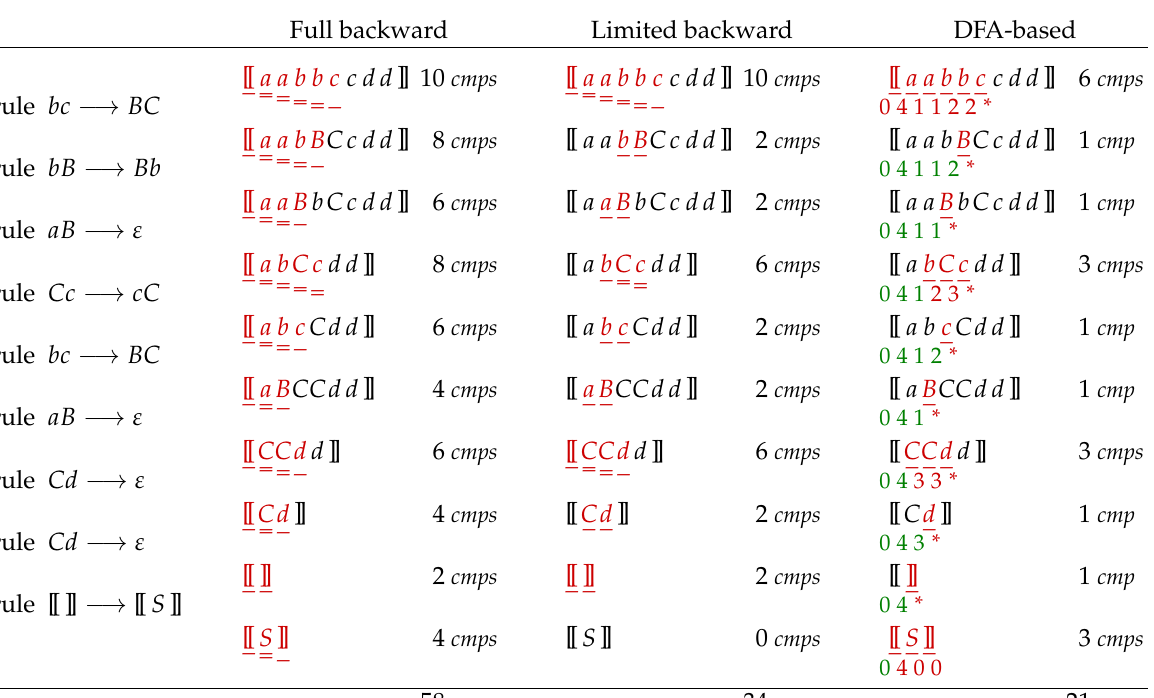
Figure 1. Comparison of parsing string aabbccdd using the LLR-system defined in Example 2 (symbols checked and states entered at each step of parsing are typeset in red and underlined, while states typeset in green were inherited from the previous step; the asterisk denotes the position where the DFA recognized the left side of a